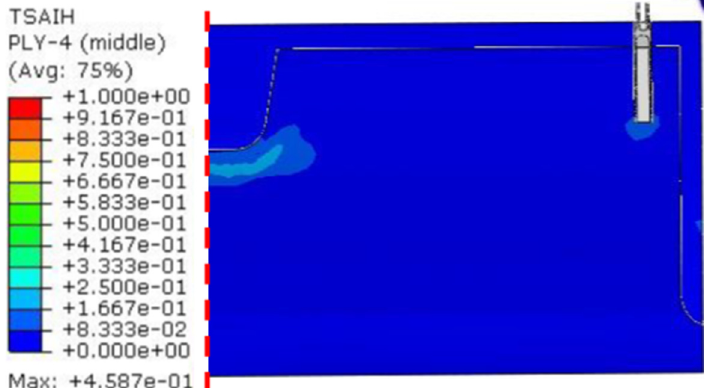
Figure 4. Tsai–Hill of baseline spoiler (bottom view and half-model presented).